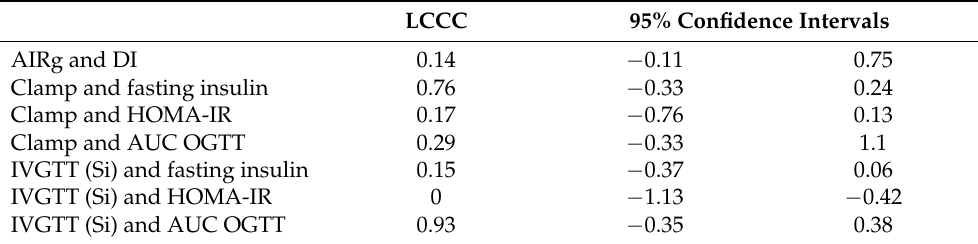
Table 4. Lin’s concordance correlation coefficient (LCCC) between gold standards and surrogate markers using proportional change data.